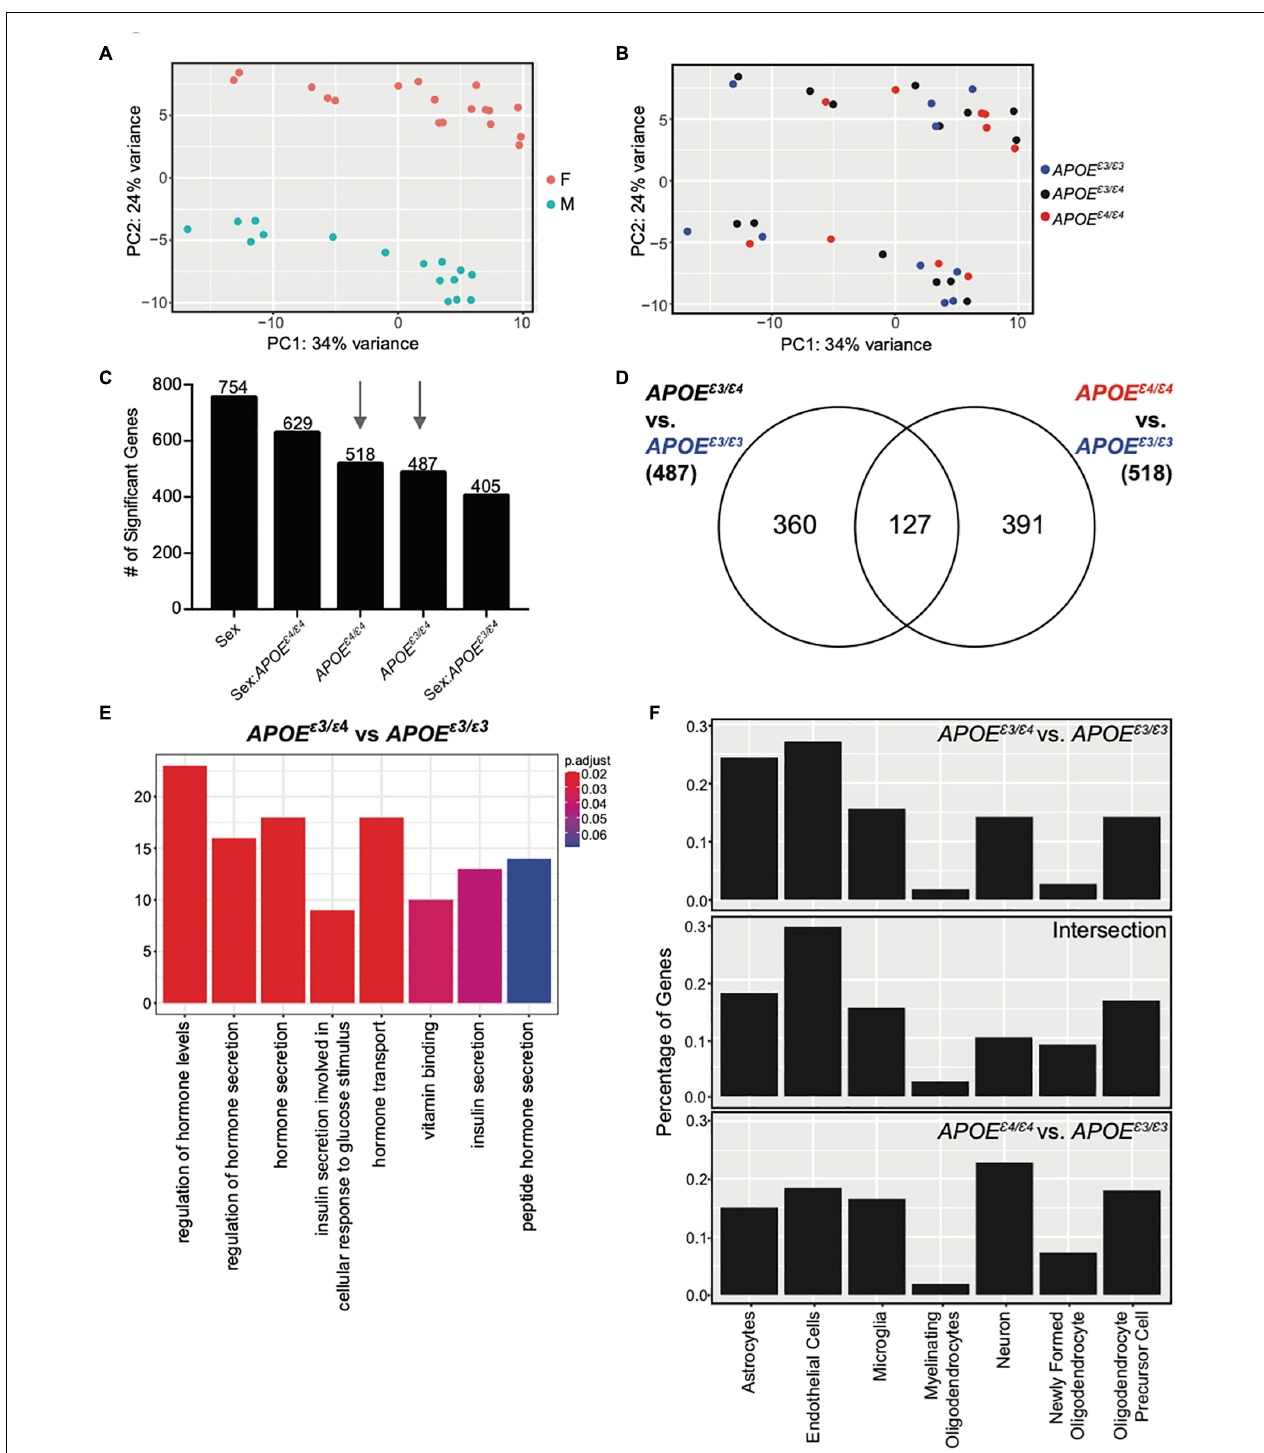
FIGURE 3 | Cortical transcriptome analysis revealed unique functional enrichment for the APOE ε 3 / ε 4 genotype at 2 months. (A) PCA showed distinct clusters of male and female samples. (B) PCA showed samples do not cluster by APOE genotype at two mos. (C) Number of significant genes for each linear model predictor term ( p < 0.05). (D) Number of significant genes unique to 2-month APOE ε 4 / ε 4 and APOE ε 4 / ε 4 when compared to APOE ε 3 / ε 3 , as well as the number of significant genes intersecting both lists. (E) Functional enrichment of the 360 significant genes ( p < 0.10) unique to APOE ε 3 / ε 4 compared to APOE ε 3 / ε 3 . (F) Percentage of genes expressed by cell type according to the BrainRNAseq